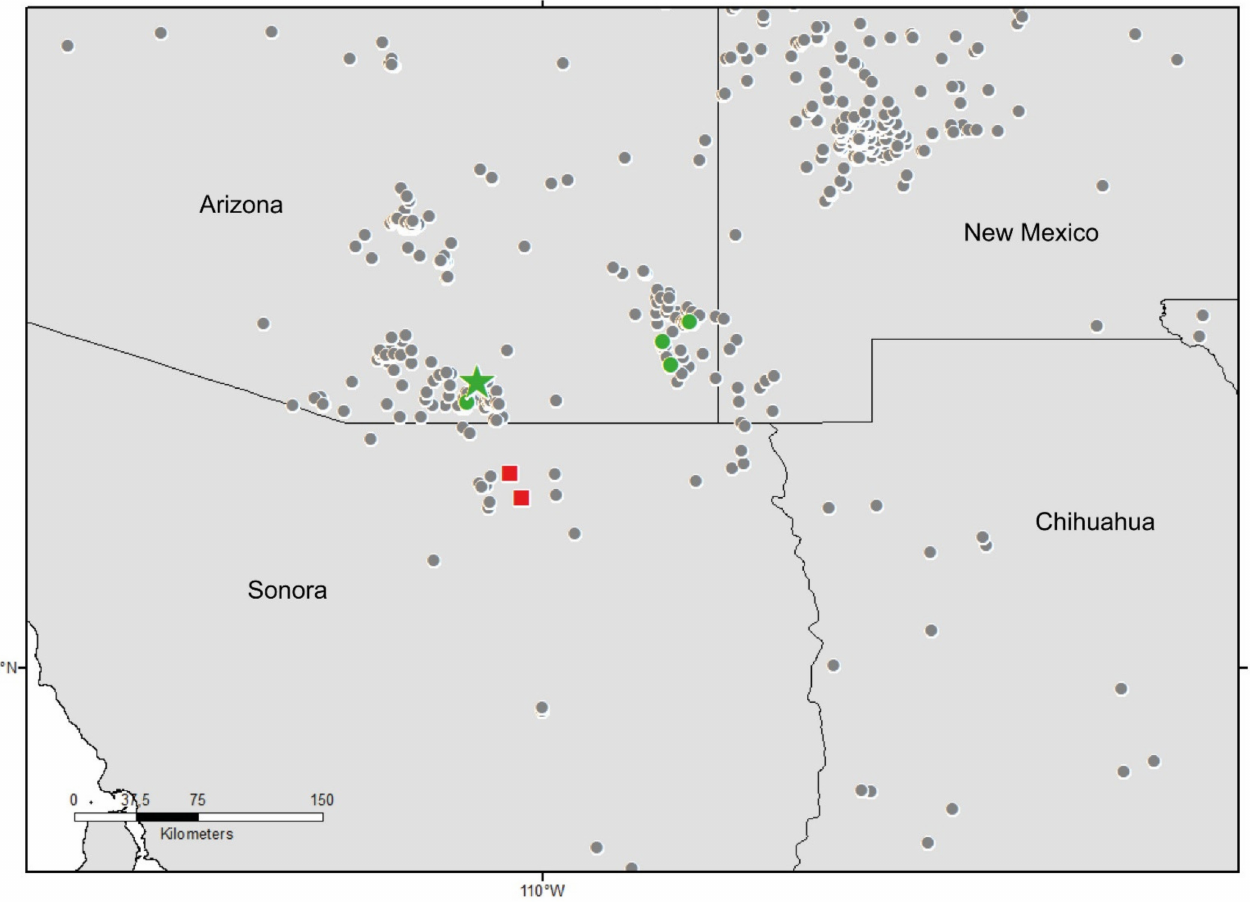
Figure 11. Map showing distributional records of Phrynosoma h. ditmarsi and P. h. hernandesi in the area of contact. Green circles = genetically confirmed records of P. hernandesi; red squares = genetically confirmed records of P. h. ditmarsi; gray circles = records that have not been genetically confirmed; green star = restricted type locality of P. hernandesi . The type locality of P. ditmarsi is too imprecise to